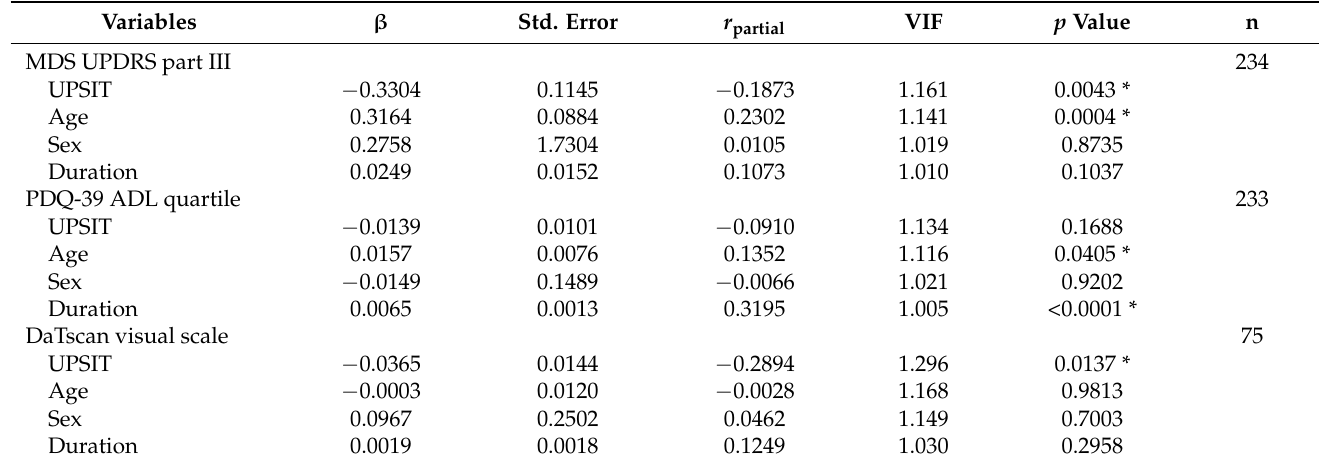
Table 4. Factors affecting MDS UPDRS part III, PDQ-39 ADL quartile, and DaTscan visual scale: multiple linear regression.